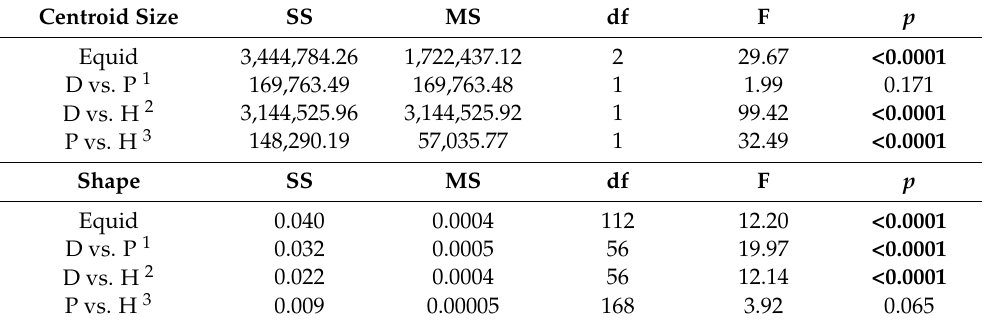
1 Comparison repeated after combination of donkey data set (D) and pony data set (P). 2 Comparison repeated after combination of donkey data set (D) and horse data set (H). 3 Comparison repeated after combination of pony data set (P) and horse data set